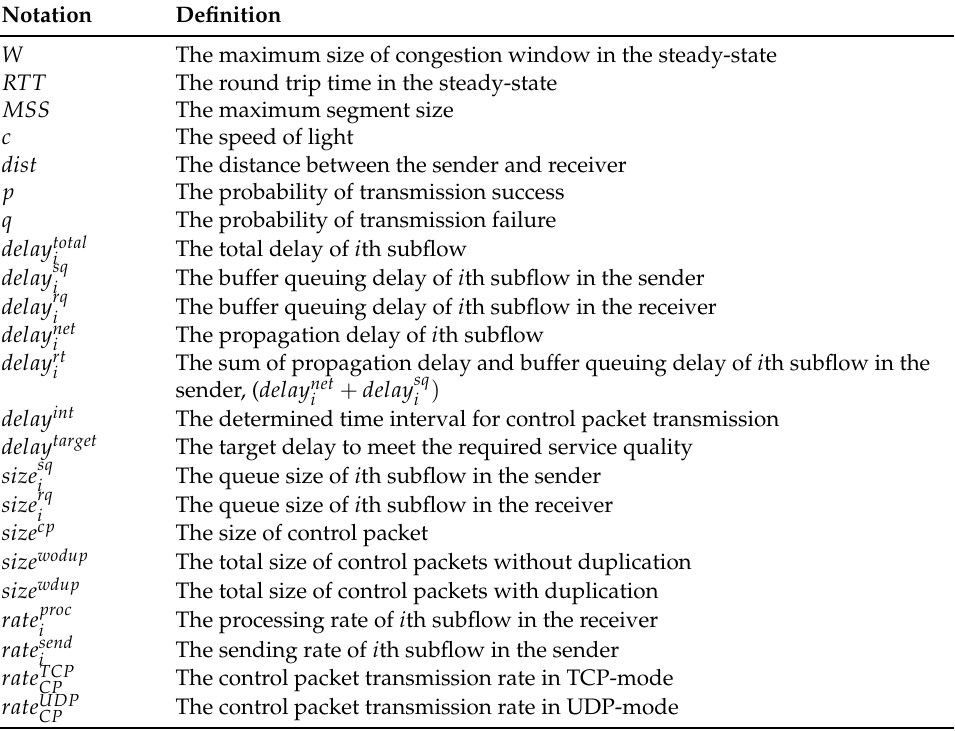
Table 1. The parameters and variables used in the